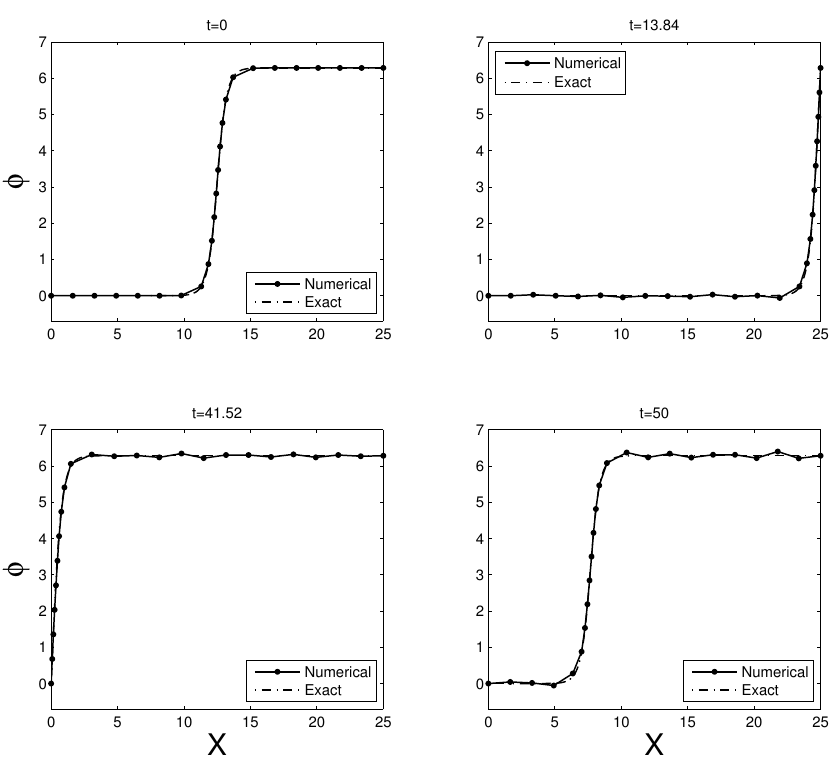
Figure 5. The single soliton solution obtained with the Lagrange multiplier strategy for N = 31: Integration in time was performed using the 4th-order Lobatto IIIA–IIIB scheme for constrained mechanical systems.